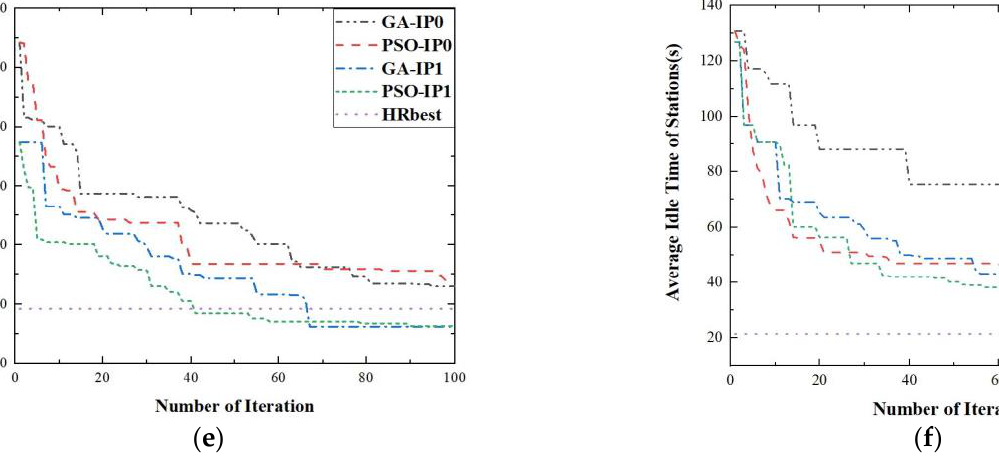
Figure 5. The graph of 100 iterations of GA-IP0, PSO-IP0, GA-IP1, PSO-IP1. ( a ) The test samples is the first set of test samples. ( b ) The test samples is the second set of test samples. ( c ) The test samples is the third set of test samples. ( d ) The test samples is the fourth set of test samples. ( e ) The test samples is the fifth set of test samples. ( f ) The test samples is the sixth set of test samples.